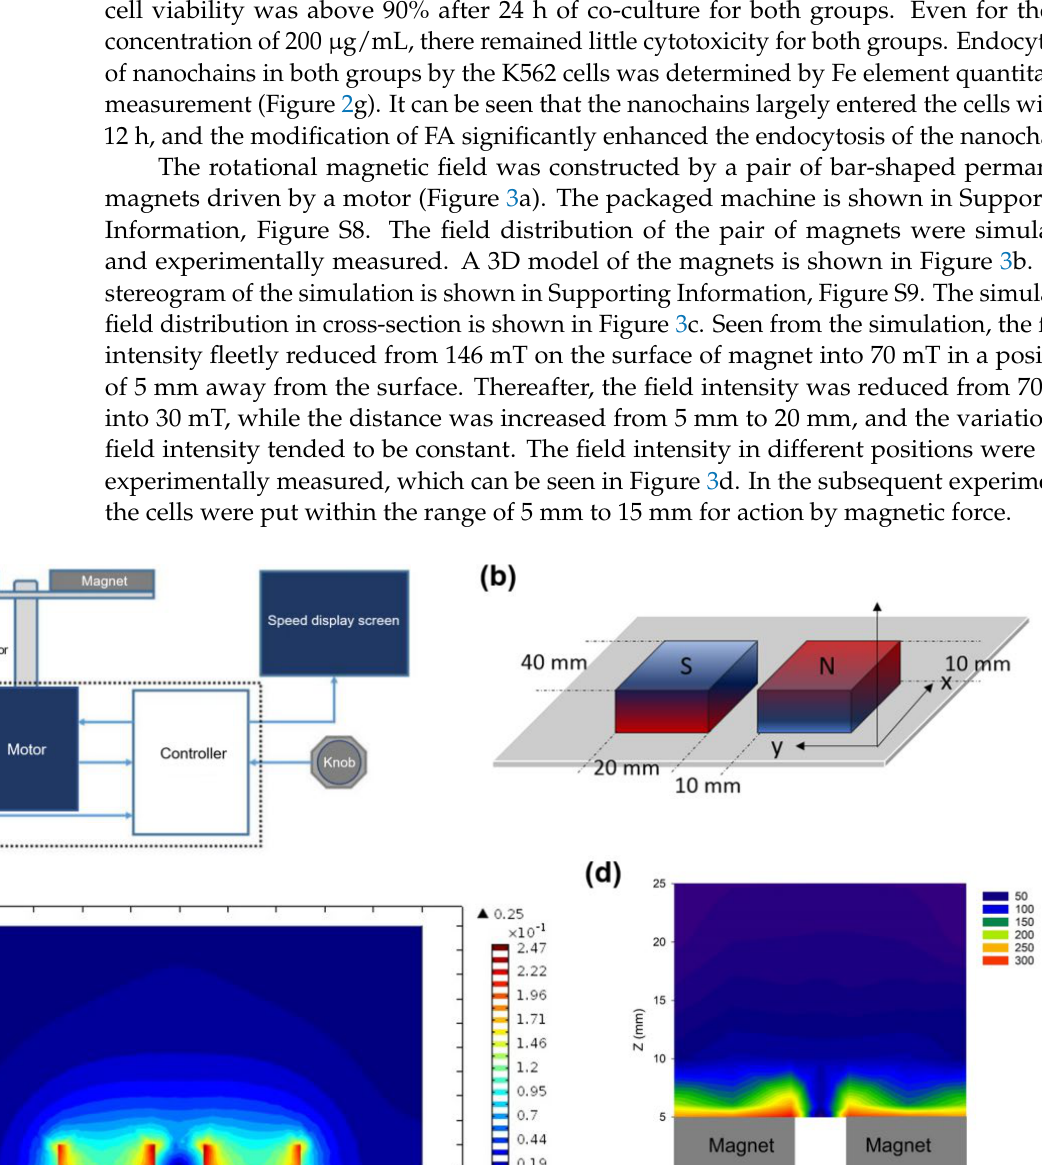
plane of the magnetic 𝑦𝑦𝑦𝑦 𝑦𝑦𝑦𝑦